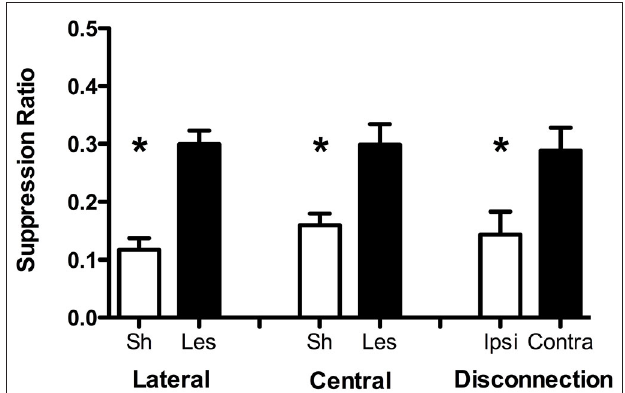
FIGURE 1 | Conditioned suppression test data from Experiment 1 for lateral (LA), CeA, and disconnection groups . Data are presented in terms of the suppression ratio ( CSresponding/CSresponding + PreCSresponding ) for each group (Sh = sham, Les = lesion, Ipsi = ipsilateral, Contra = contralateral). Error bars reflect standard error of the mean. Asterisks indicate statistical significance ( p < 0.05). Final sample sizes are as follow: LA sham = 27, LA lesion = 12, CeA sham = 14, CeA lesion = 10, ipsilateral = 7, contralateral =